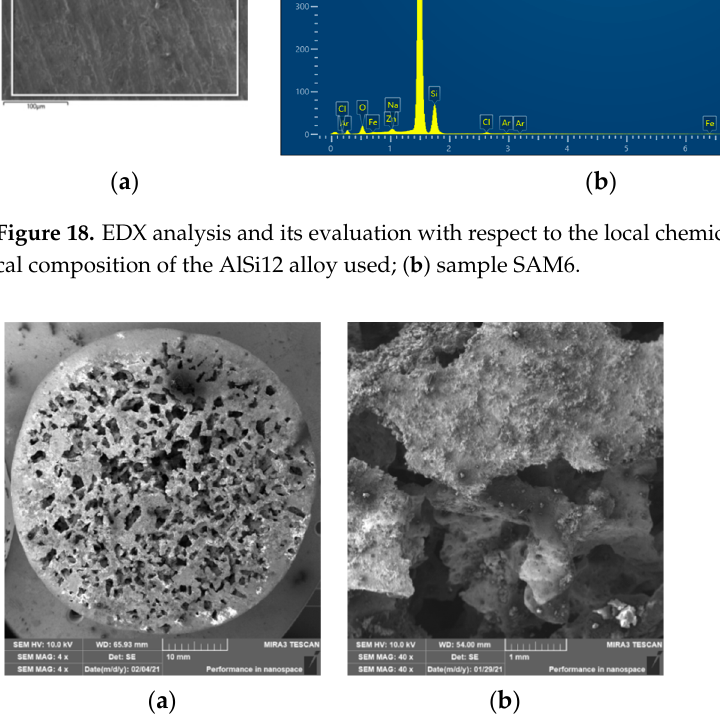
Figure 19. View of the structure of the porous material of AlSi12 alloy: ( a ) detail of the material; ( b ) scanning electron microscope image (Vega 3 Tescan, SEM HV 20.0 kV) of sample SAM7.